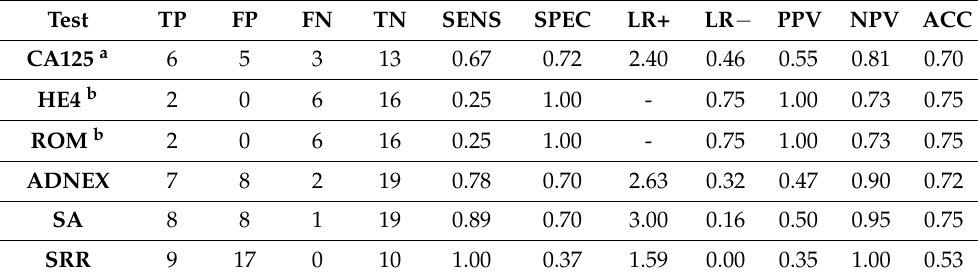
Table 5. Predictive values of the diagnostic tests used in the study.